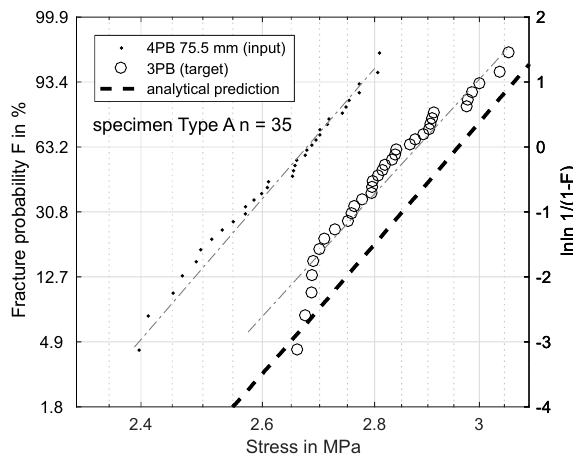
Figure 6. Specimen Type A: prediction of fracture probability from 4PB (75.5 mm) to 3PB.